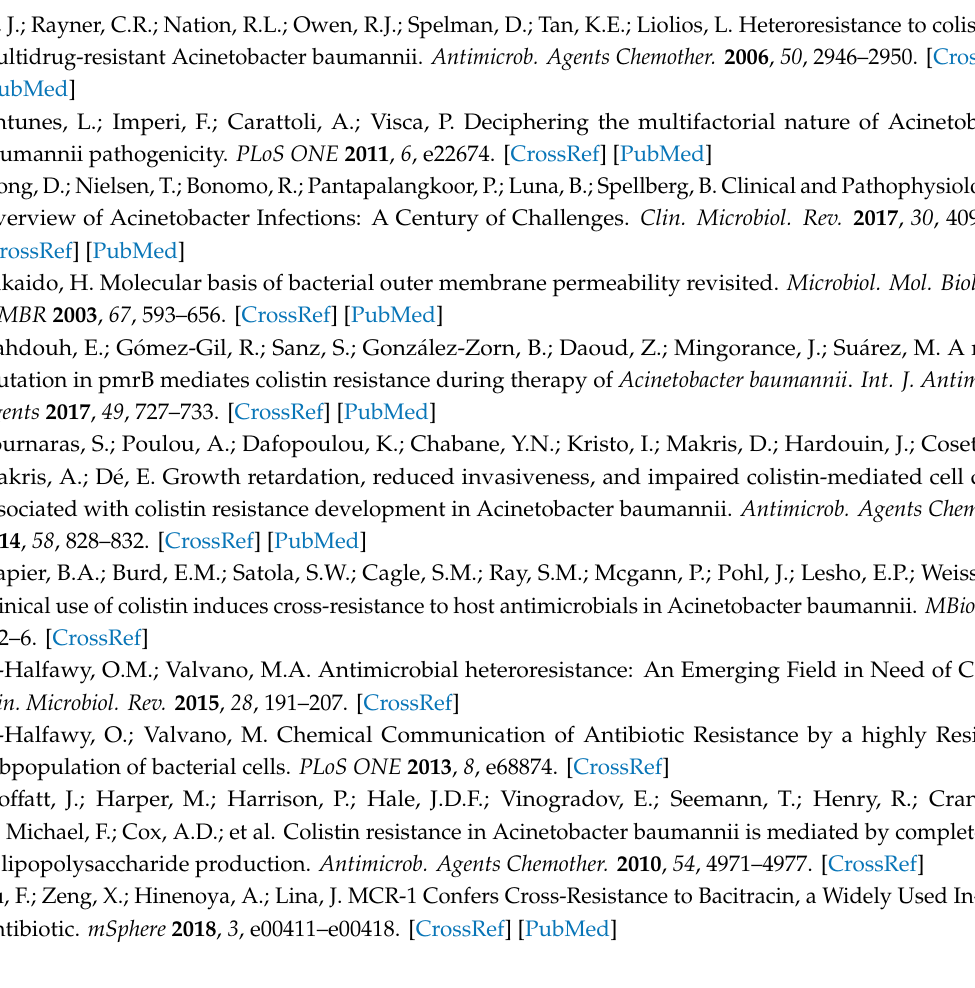
Table S1: Comparison of colistin MIC determination using the disc di ff usion and microdilution methods for selected clinical A. baumannii